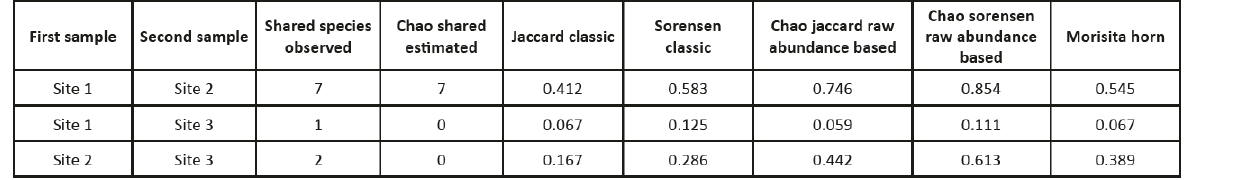
Table 3. Shared specfies analysfis between three ecosystems